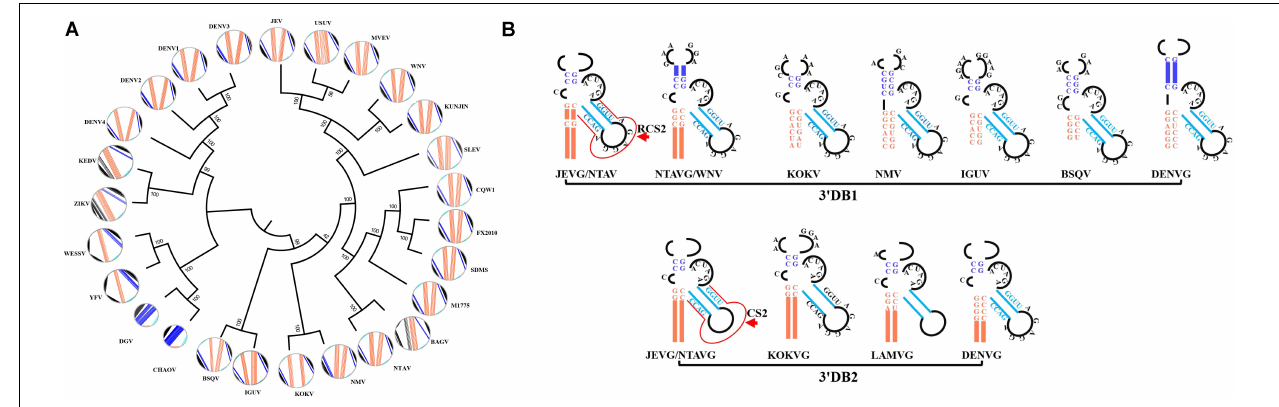
FIGURE 6 | The consensus structure of divergent DB regions within MBFVGs. (A) Molecular phylogenetic analysis of the DB sequences. A fan dendrogram indicating the distance between these structures is shown as corresponding circle plot with the sequence and arcs denoting base pairings. The color code for each structural motif is maintained in all the representations. The unrooted phylogenetic tree was built with the maximum likelihood method using MEGA7, based on the alignment of the DB sequences. (B) Overview of the bottom part of the consensus dual-DB common to different MBFVs. The highly conserved nucleotides in the individual local secondary structure are annotated in the same color as in panel (A) . Meanwhile, the thick colored lines represent the conserved RNA structure in each classified group. The RCS2 and CS2 are marked by arrow in JEVG DB1 and DB2, respectively.